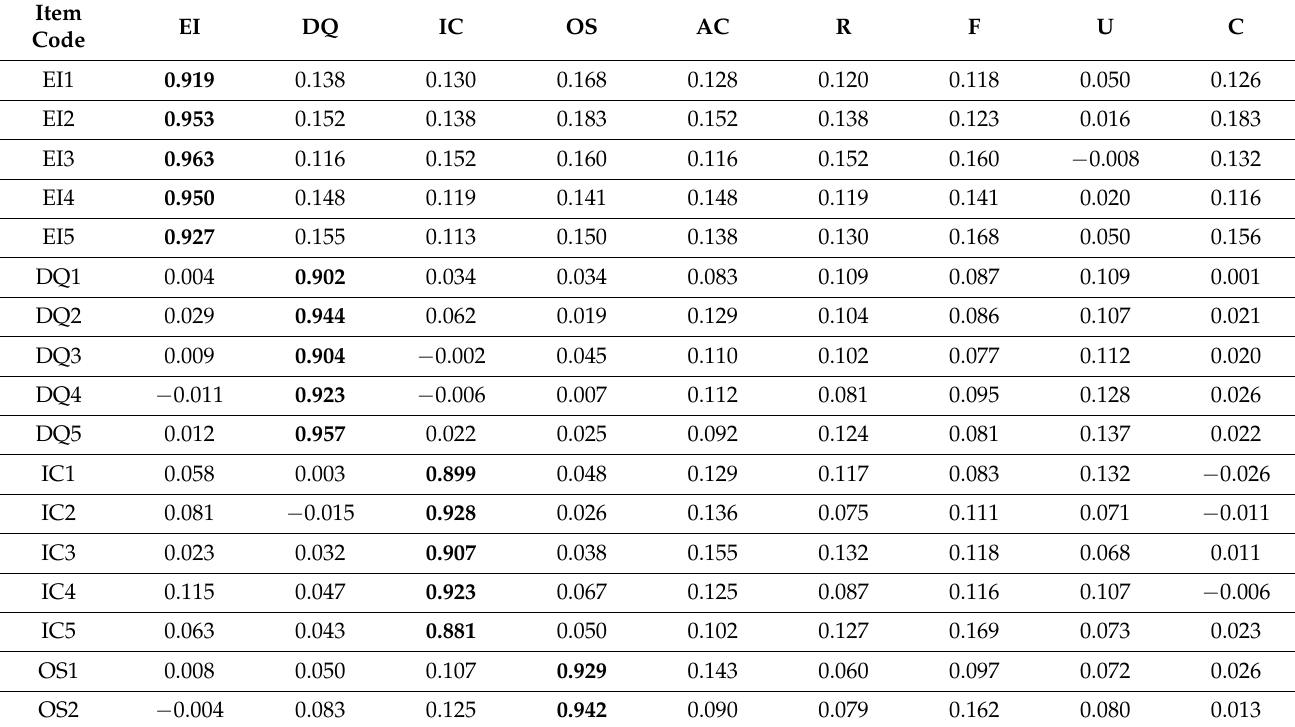
Table 2. Loadings and cross-loadings.